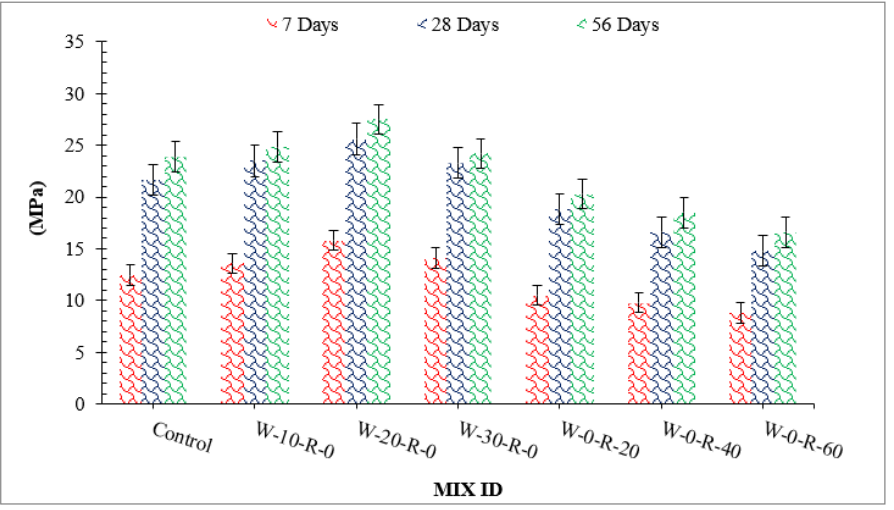
Figure 5. Compressive